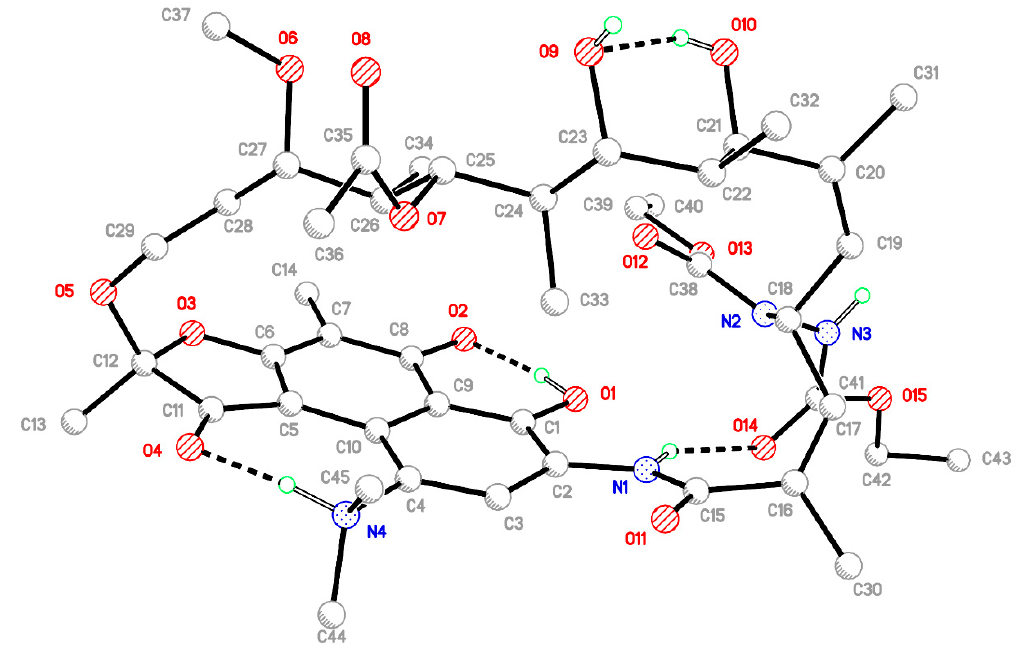
Figure 2. A view of a molecule of compound 3 from the crystal structure showing the atom numbering scheme employed and the intramolecular hydrogen bonds as dashed lines. In this figure, the structure is viewed obliquely from above the naphthalene ring. C-H hydrogen atoms have been removed for clarity.